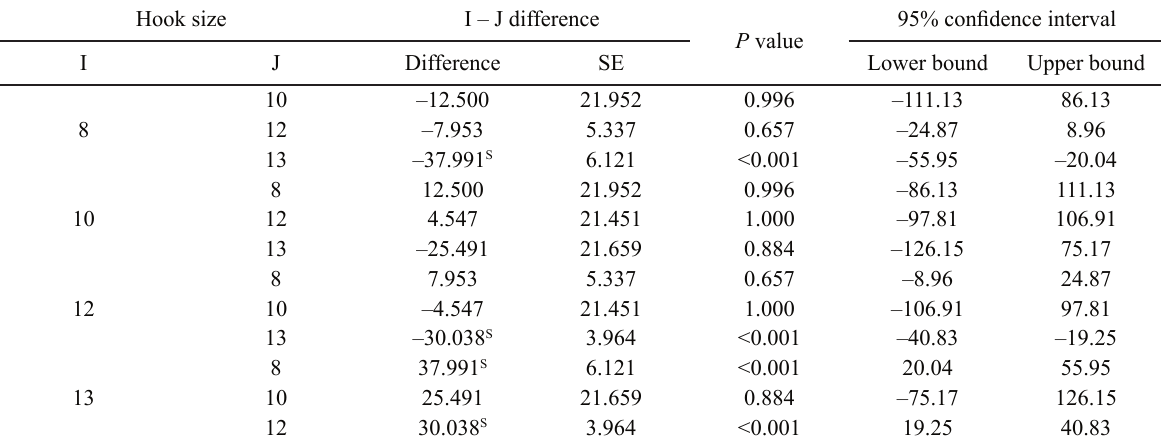
Summary of post-hoc test, for multiple comparisons of hook size